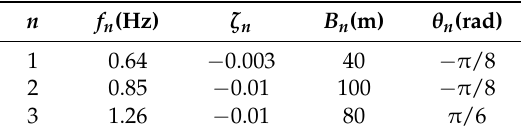
Table 1. The parameters in Equation